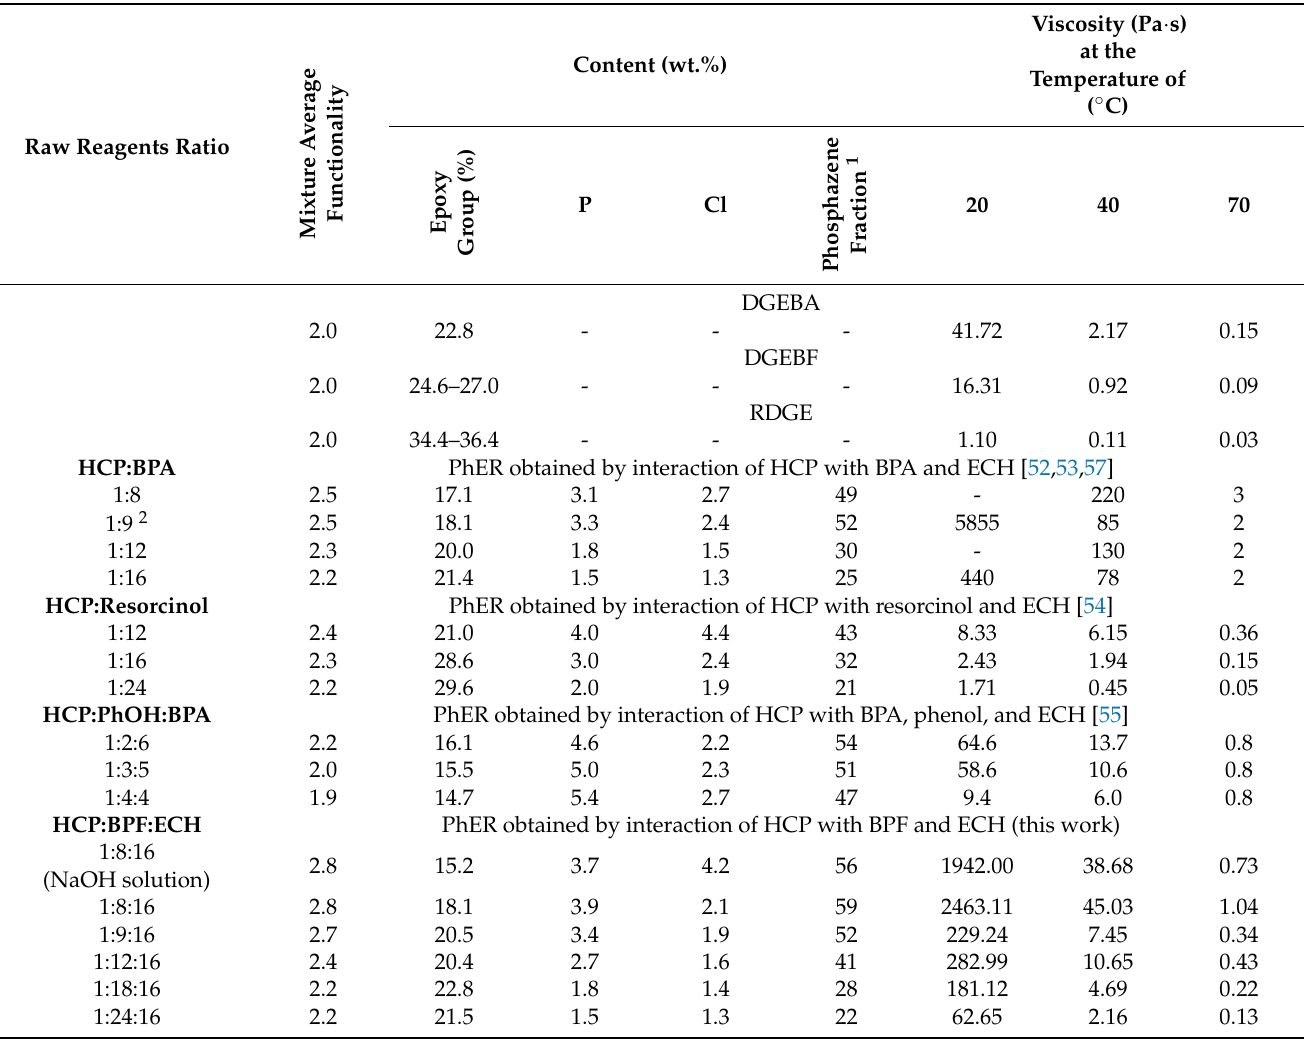
Table 6. Comparison of technological characteristics of base and phosphazene-containing epoxy resins based on basic diphenols and the content of phosphorus and chlorine between different PhER. The content of P and Cl wt.% in PhER obtained in this work, determined by X-ray fluorescence spectrometry.